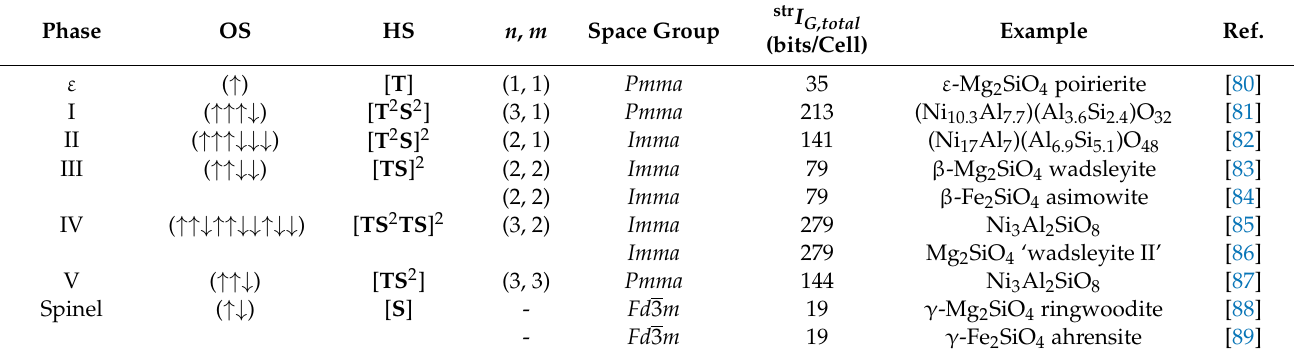
Figure 9. The crystal structure of ‘wadsleyite-II’, featuring borders and orientations of spinel modules. The numbers above provide the widths of the spinel blocks in terms of the numbers of modules between the two T -planes. Table 3. Total structural complexities for basic spinelloid structure